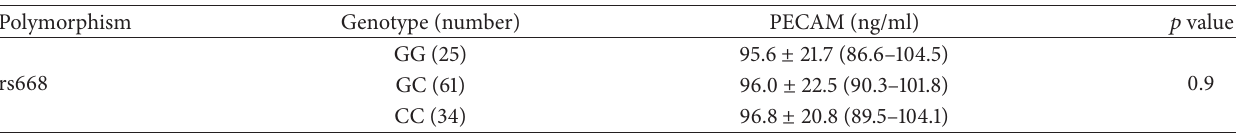
Values are mean ± SD (95 % confidence